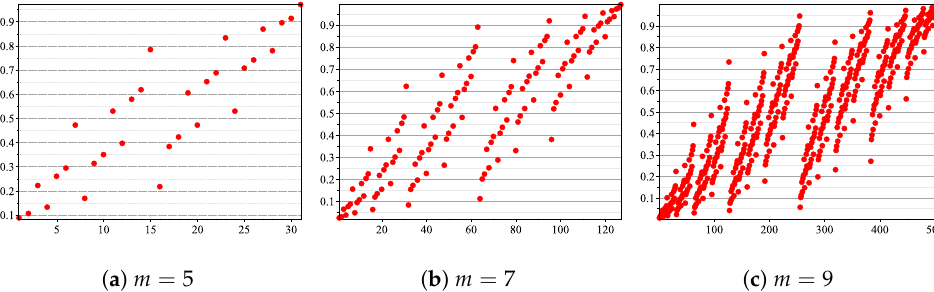
Figure 2. Average Bhattacharyya parameter. On the x-axis are the integer values of the binary vectors m , and on the y-axis are the values Avr ( ( W u )) . u 0,1 ∈ { } B v The preorder u Avr ( W u ) Avr ( W v ) induces a complementarity ≤ Avr ⇔ ≤